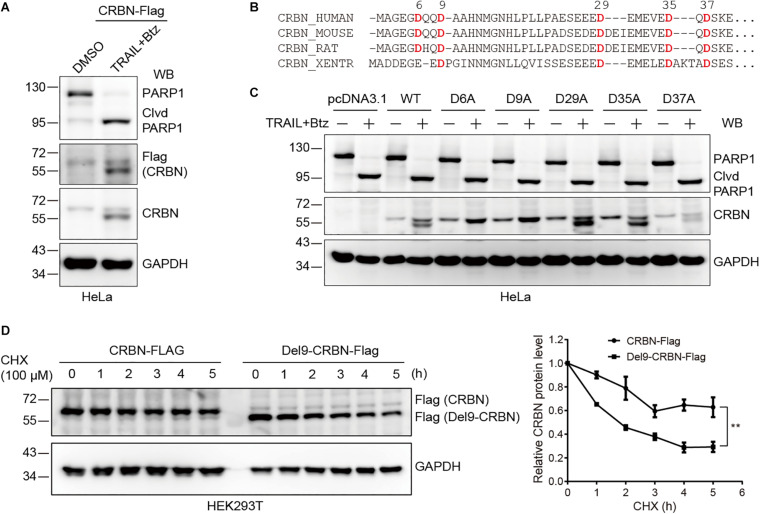
Cleavage of CRBN at Asp9 (D9) reduces its stability. (A) CRBN is cleaved at the N-terminus upon CASP-8 activation. HeLa cells were transfected with CRBN-Flag plasmid for 48 h and treated with DMSO or TRAIL (100 ng/ml) and Btz (0.5 μM) for 24 h. The resulting cell lysates were subjected to immunoblotting analysis. (B) Amino acid sequence alignment for CRBN from human, mouse, rat, and western clawed frog (Xentr). Conserved Asp (D) residues were indicated in red. (C) CRBN is cleaved at Asp9 (D9) upon CASP-8 activation. HeLa cells were transfected with the WT and CRBN Asp (D) to Ala (A) mutants for 48 h and then treated with DMSO or TRAIL (100 ng/ml) and Btz (0.5 μM) for 24 h. Cell lysates were used for immunoblotting. (D) Deletion of the N-terminal nine amino acids in CRBN reduces it stability. WT CRBN and Del9-CRBN mutants were expressed in HEK293T cells and split to 24-well plates. At 48 h post-transfection, cells were further treated with cycloheximide (CHX, 100 μM) for the indicated time. The cell lysates were immunoblotted with the indicated antibodies. Mean ± SEMs were from three independent biological replicates. Two-way ANOVA, **P < 0.01; Clvd, cleaved.